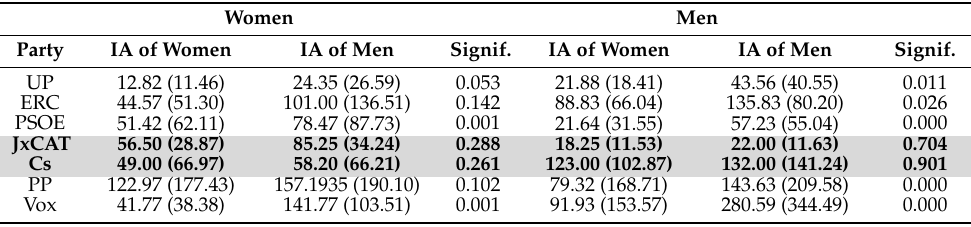
Table 8. Internal amplification (IA) of women and men by party and